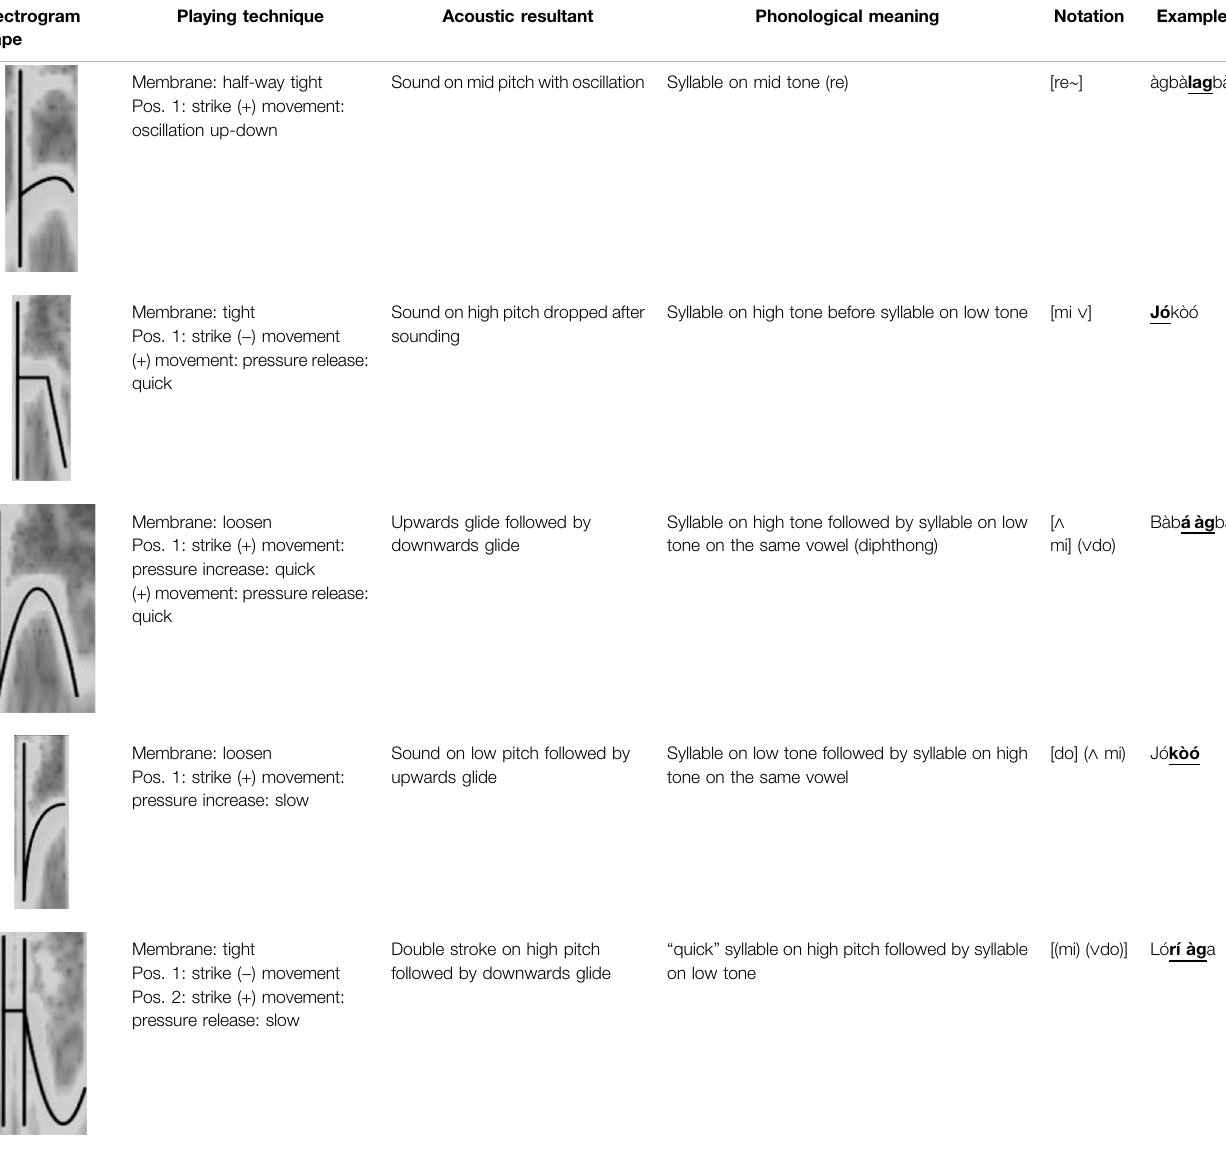
TABLE 1 | ( Continued ) The phonology of the dùndún . The black shapes on the spectrogram images were manually added by the researchers to facilitate